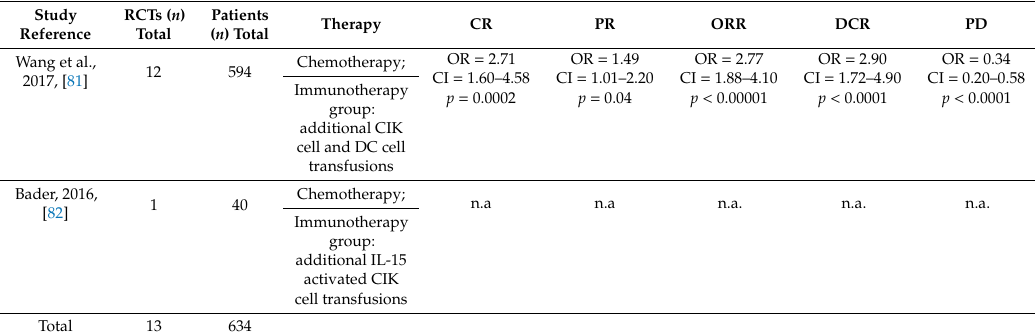
Table 5. Clinical studies applying CIK cells for the treatment of hematological